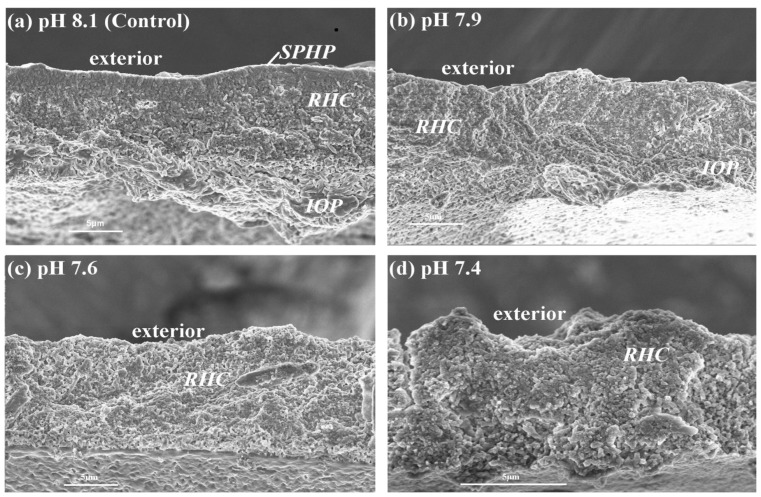
Effects of pCO2 on fracture surfaces of the tube ultrastructures in the juvenile tubeworms, Hydroides elegans.Abbreviations: SPHP, spherulitic prismatic structure; IOP, irregularly oriented prismatic structure; RHC round homogenous crystal structure.